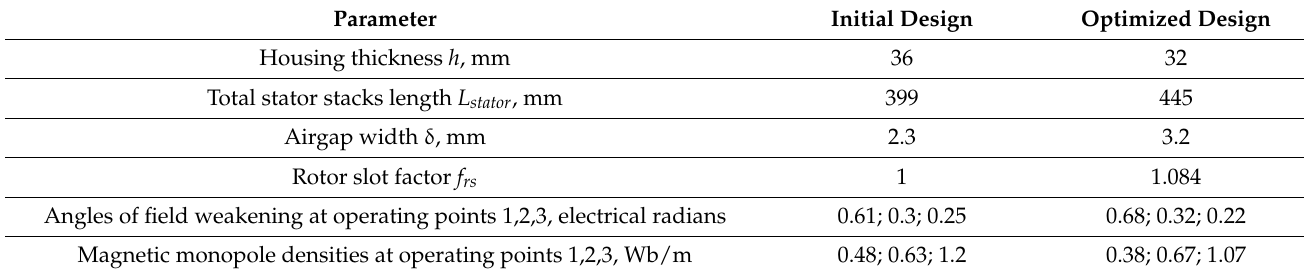
Table 3. Geometric parameters varied during the